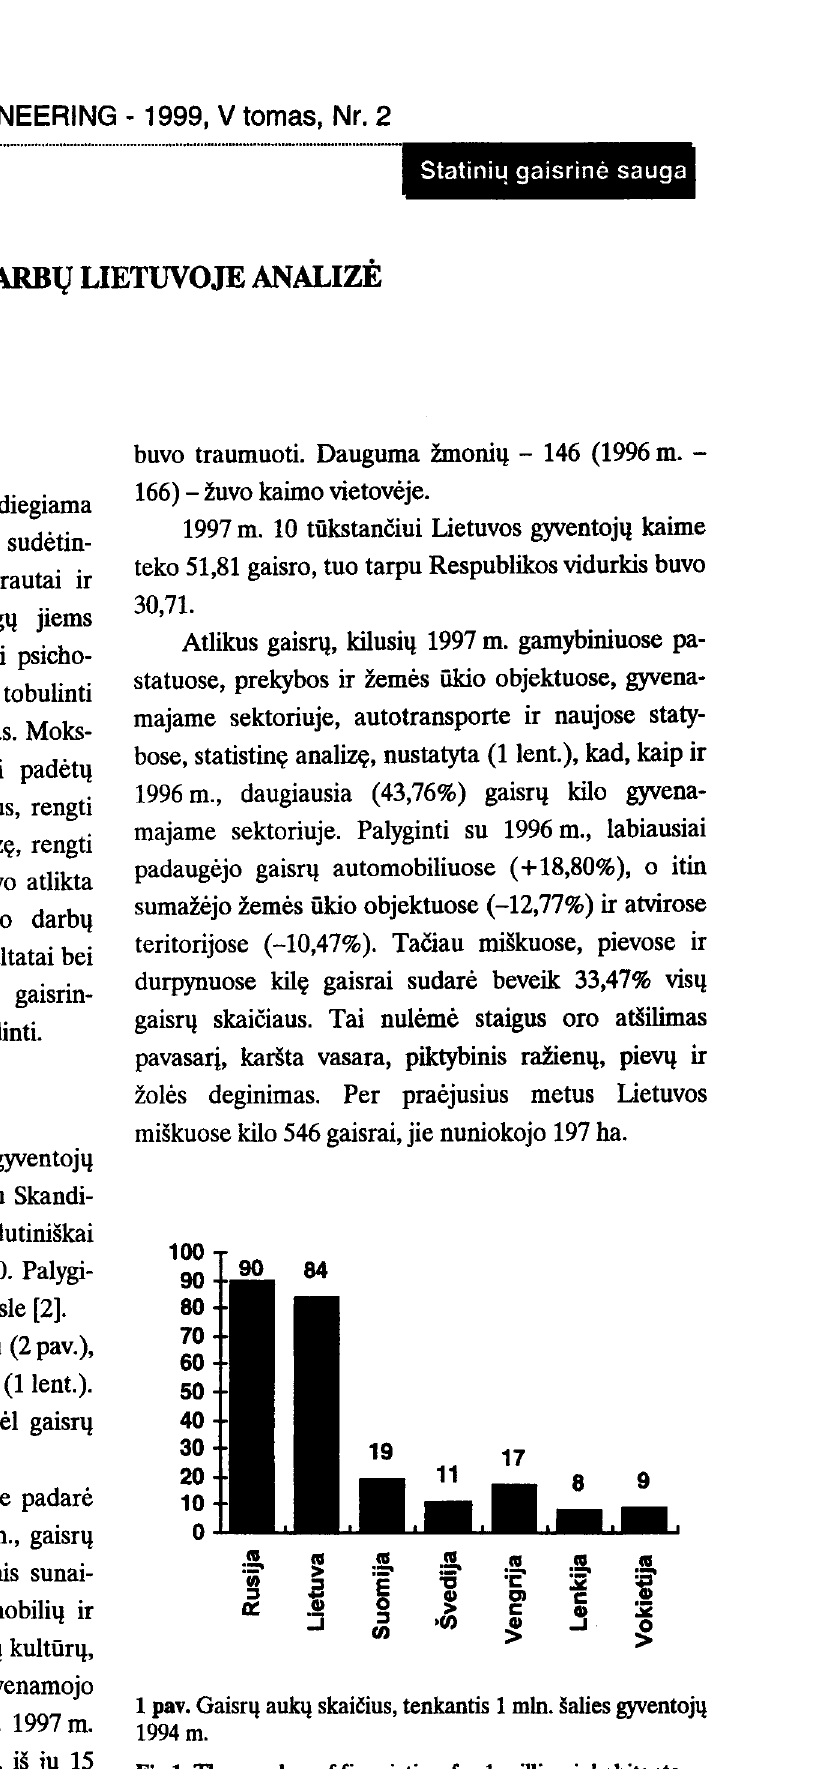
Fig 1. The number of fire victims for 1 million